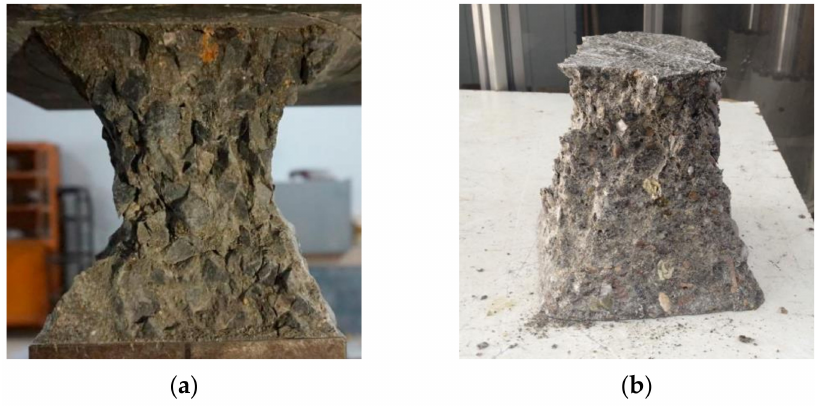
Figure 3. Compression failure of RAC without fibers: ( a ) [67]; ( b ) [68].